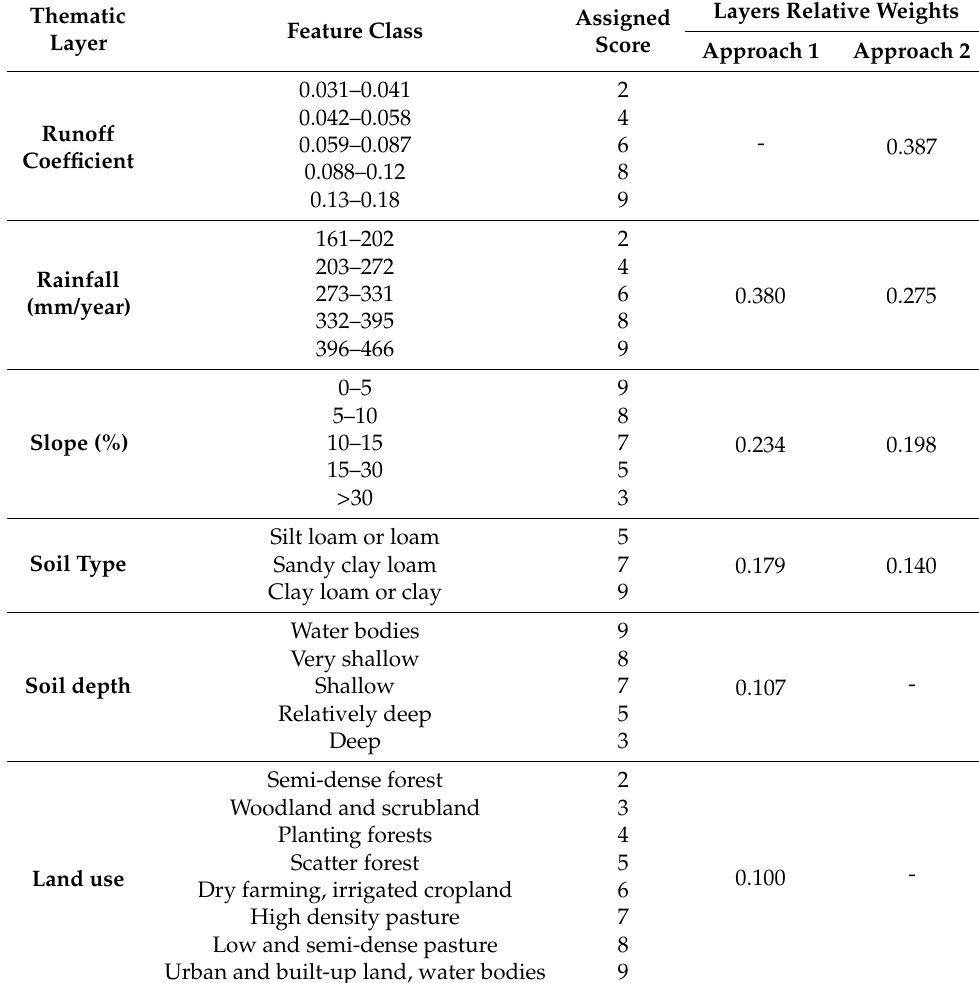
Table 3. Weights of the thematic layers (criteria) and their features